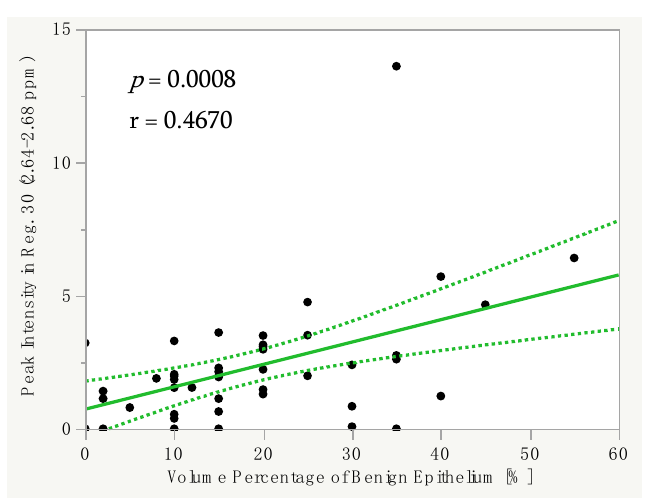
Figure 3. Linear correlation between the Vol.%Epi and the spectral peak intensity in Reg. 30 (2.64–2.68 ppm) in all groups. Dotted line = confidence interval. Abbreviations: Vol%Epi = volume percentage of benign epithelium, ppm = parts per million, Reg. = region.